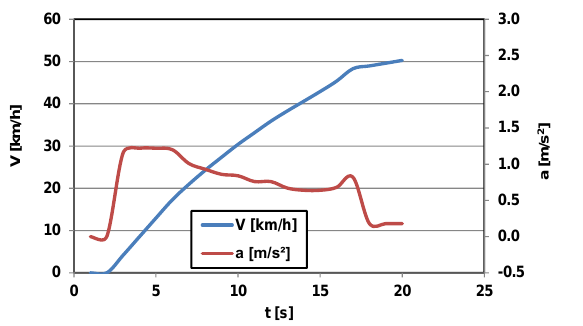
Fig. 8. Characteristics of speed and acceleration of the vehicle as a func- tion of simulation time; mapped on the basis of a real acceleration test